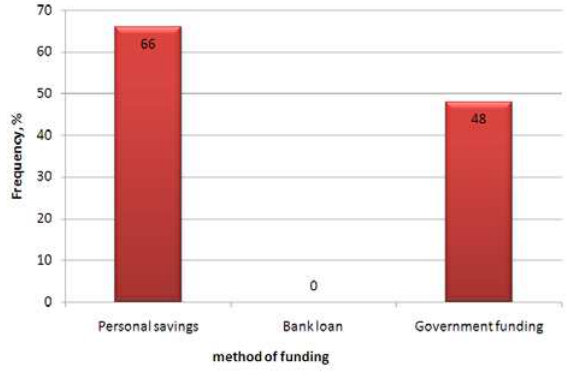
Fig. 3. Age distribution of participants